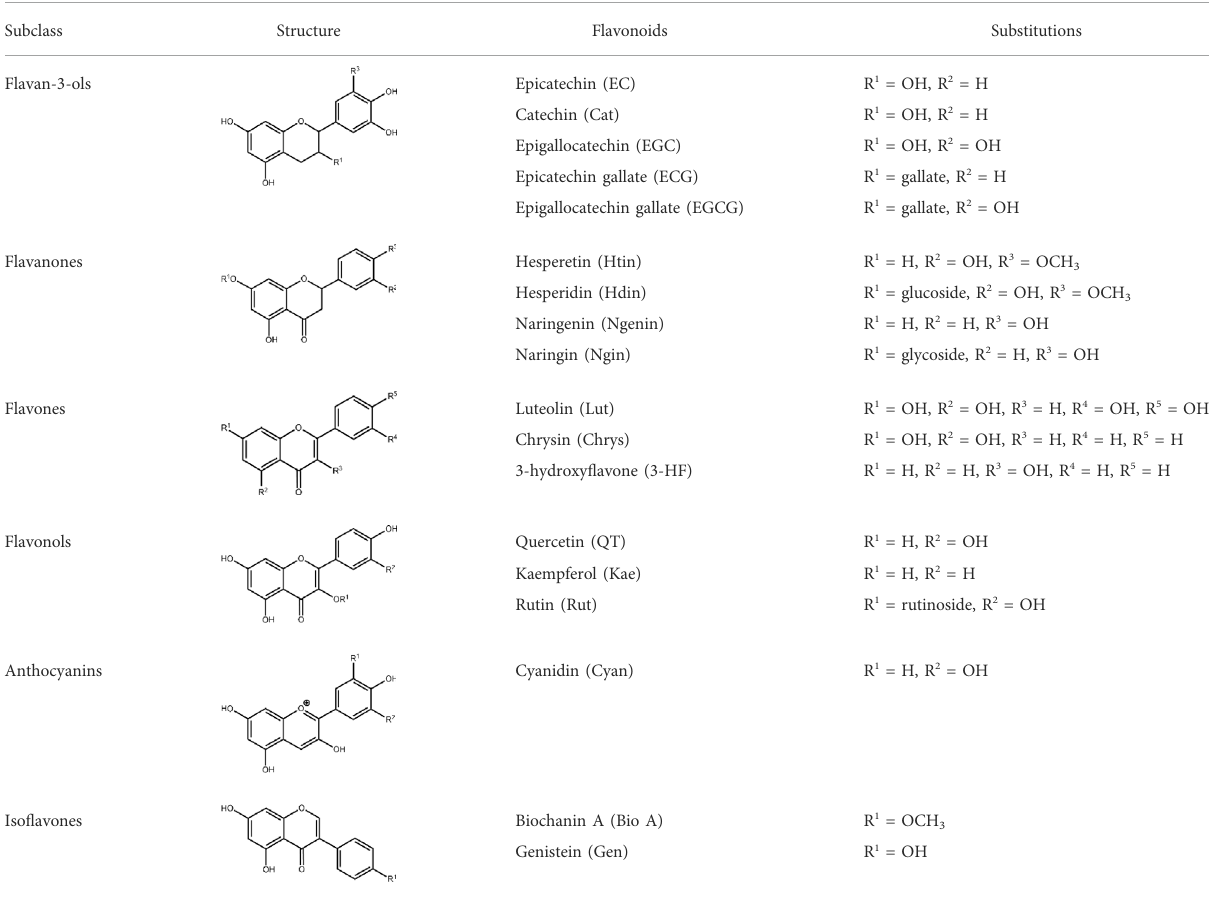
TABLE 1 Structures and subclasses of fl